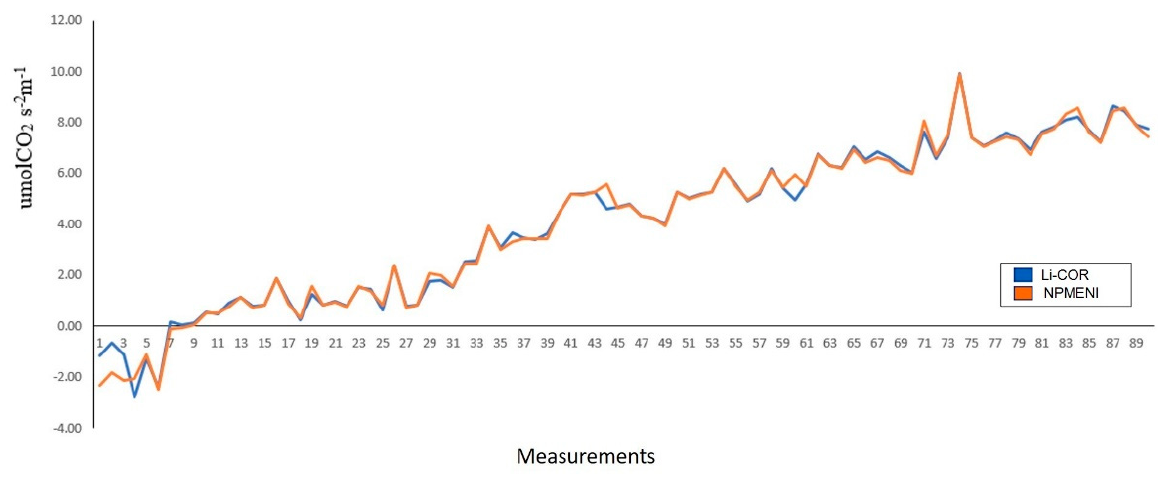
Figure 16. Comparison of net photosynthesis estimation using the LI-COR Li-6800 equipment and the NPMENI equipment.